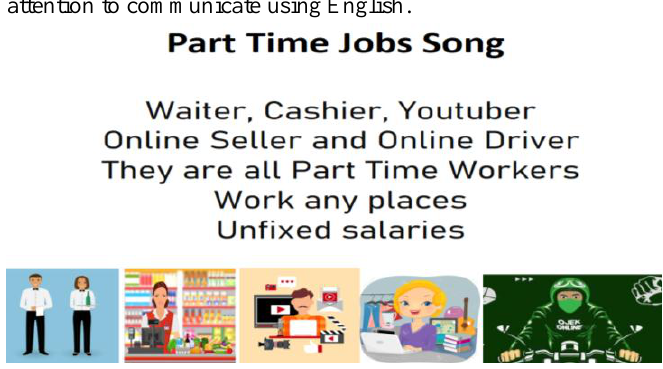
FIGURE 10 | Part Time Jobs Song’s